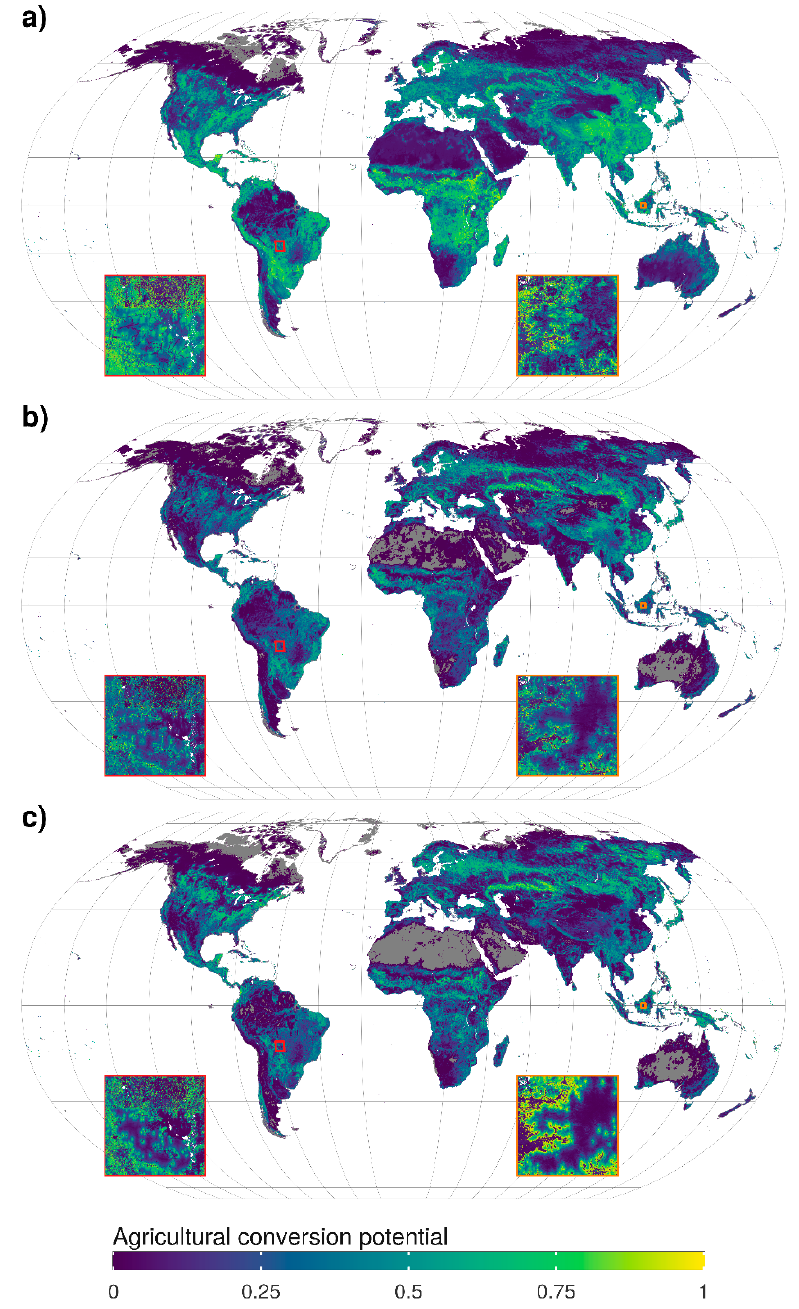
Figure 2. Global conversion potential maps for the three agricultural categories: ( a ) cropland only, ( b ) mosaics with >50% crops, and ( c ) mosaics with <50% crops. For visualization purposes, the global maps were resampled to a spatial resolution of 5 arc-minutes (~10 km) and displayed in Robinson projection. Areas with probabilities close to zero (1‰ cut-off value) are shown in grey. Inset maps are displayed at the original 10 arc-seconds resolution.